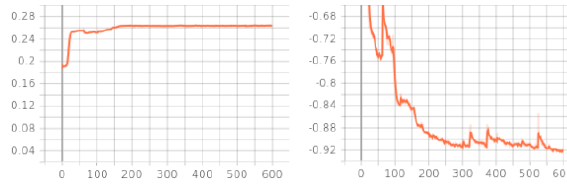
Figure 4. Standard deviation of the l 2 -normalized output and training loss.